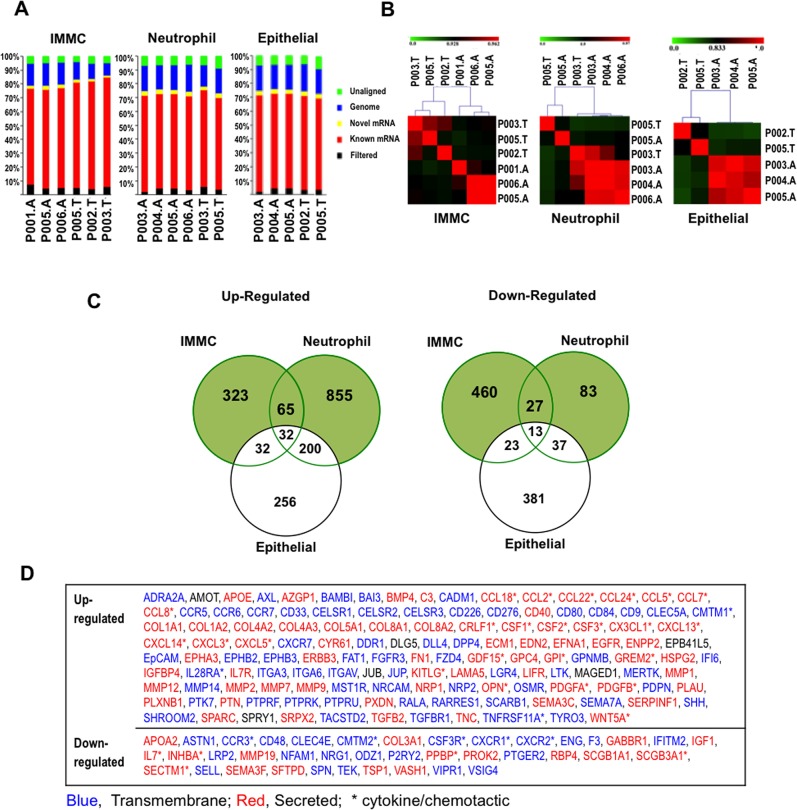
RNA-seq analysis of BM immature monocytic myeloid cells and epithelial cells from NSCLC patients and controls.(A) Summary of RNA-seq reads from adenocarcinoma (tumor)- and adjacent lung-derived IMMCs (immature monocytic myeloid cells), neutrophils, and epithelial cells isolated from 6 adenocarcinoma patients and mapped to known human mRNA, genome, and novel mRNA of Aceview gene model. P, unique patient identifier; A, adjacent non-neoplastic lung tissue; T, neoplastic tumor tissue. (B) Spearman correlation analysis showing clustering of stromal cells derived from IMMCs, neutrophils, and epithelial cells based on global RNA-seq gene expression profiles into distinct tumor and adjacent lung groups. P, unique patient identifier; A, adjacent non-neoplastic lung tissue; T, neoplastic tumor tissue. (C) Venn diagrams showing total number of differentially expressed genes in immature IMMCs, neutrophils, and epithelial cells from adenocarcinoma compared to non-neoplastic adjacent lung. Cutoff of at least 50 unique mapped reads and FDR <5%. The genes in the list show differential expression with p<0.05, and fold change >2. (D) Differentially regulated stromal genes from (C), enriched for potential paracrine functions as determined by Gene Ontology annotation as secreted, extracellular space, or membrane (except membranes of organelles including golgi and endoplasmic reticulum). Of these, genes with the functions in key tumorigenic pathways including angiogenesis, ECM breakdown, cell migration, proliferation, invasion, cytokine function, chemokine function, and chemotactic function were selected. Genes selected for analysis are denoted in blue, transmembrane; red, secreted.